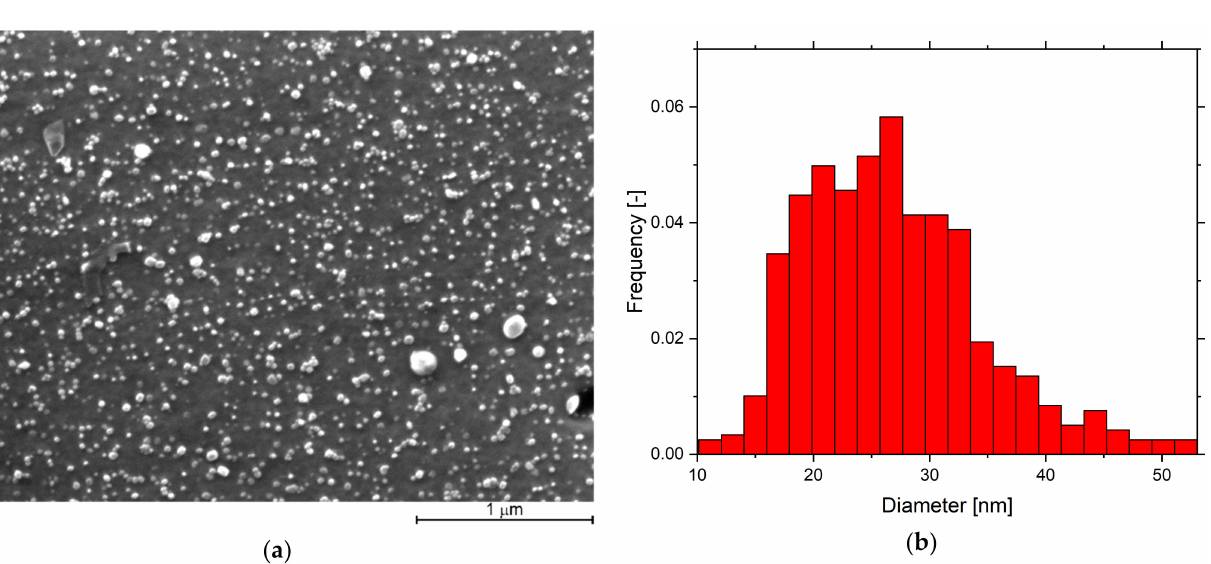
Figure 5. X-ray diffraction data measured on specimens’ surface after the tensile test in air atmosphere. An example of typical nano-oxide dispersion (practically independent of Y and Cr content) and its size distribution histogram in recrystallized grains is presented in Figure 6. The fracture mechanism of the Fe-10Al-4Cr-4Y 2 O 3 ODS specimen alloy with 1.25 Y (with the highest strength) can be deduced from Figure 7. Here, it is clearly shown that the fracture is initiated in an unrecrystallized and much softer region in the central part of the specimen (some other unrecrystallized regions are also revealed in Figure 3e). This region can be considered as a defect, and one can expect that it could be removed by annealing at 1200 ◦ C for a longer time than 4 h to fully complete secondary recrystallization.